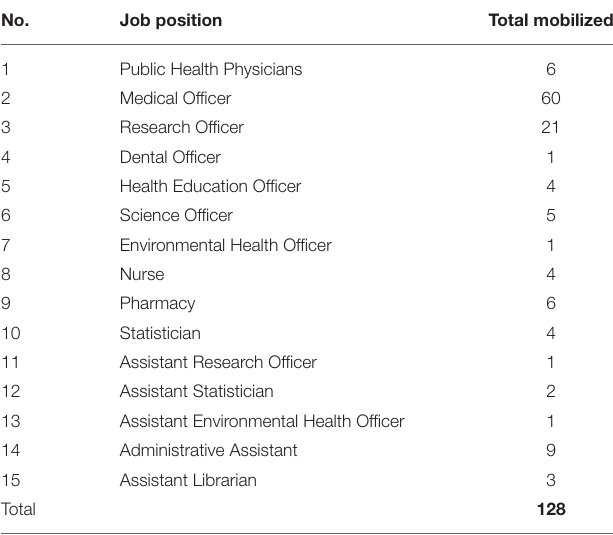
TABLE 3 | Number of mobilized personnel by job